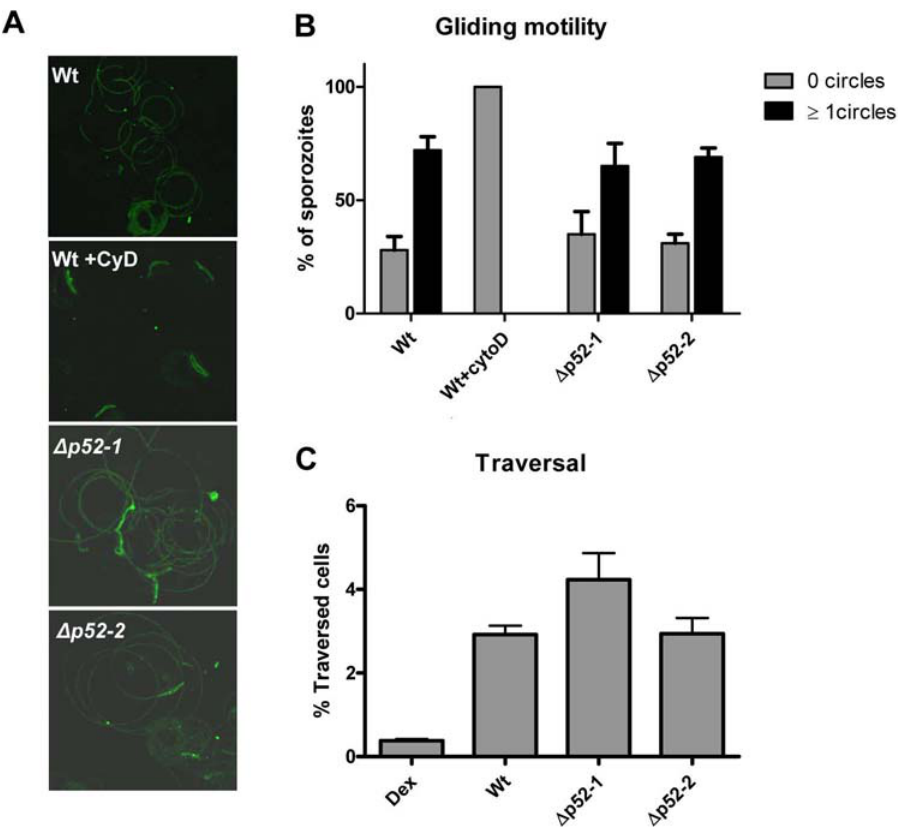
Figure 2. Gliding Motility and Traversal Capacity of Wt and D p52 sporozoites. (A) Representative immunofluorescence staining with anti- PfCSP antibodies of the trails produced by Wt and mutant sporozoites deficient in P52 expression ( D p52-1 and D p52-2 ) as well as Wt sporozoites, treated with cytochalasin D, an inhibitor of sporozoite motility. Characteristic circles of gliding motility are present in Wt and mutant lines, and absent in Wt sporozoites that have been treated with cytochalasin D. (B) Gliding motility of P. falciparum Wt (cytochalsin D treated and untreated) and mutant sporozoites as assessed by the capacity to produce the characteristic circles (see A). (C) Cell traversal ability of P. falciparum Wt and mutant sporozoites as determined by FACS counting of Dextran positive hepG2 cells. Dex: hepatocytes cultured in the presence of Dextran but without the addition of sporozoites.